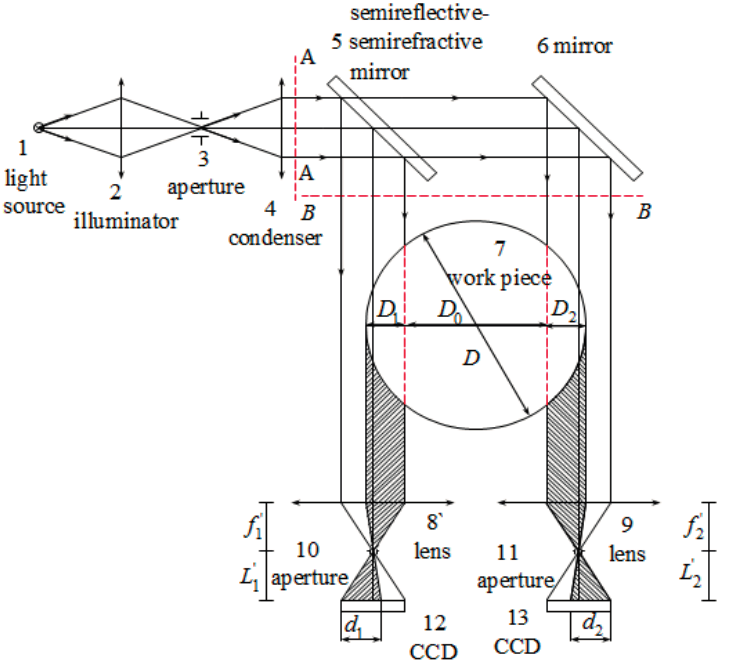
Figure 1. The optical principle of the parallel light projection method with double light paths (with permission from [8]).